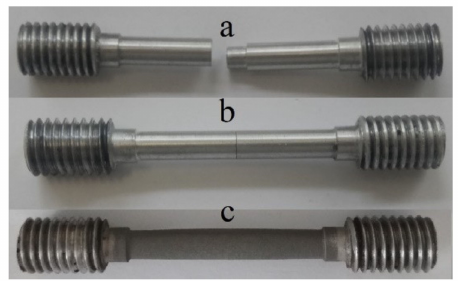
Figure 4. The sample for cohesive strength tests: ( a ) before spraying, disassembled; ( b ) before spraying, assembled; ( c ) after spraying,